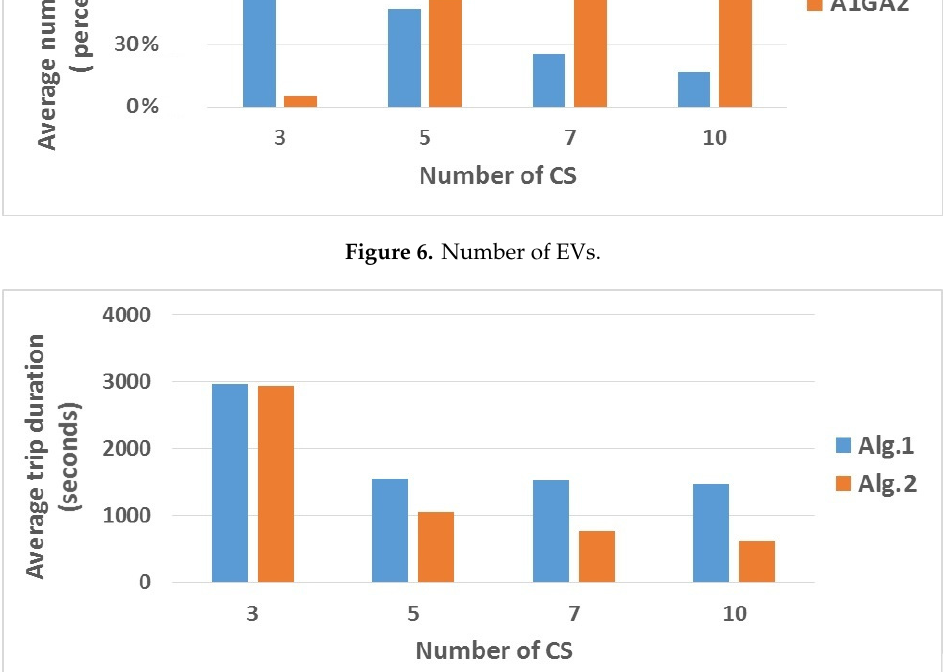
Figure 7. Average trip duration.